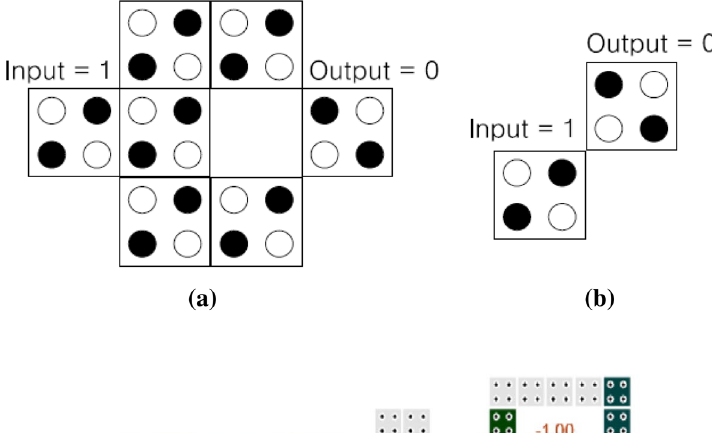
Fig. 3 The QCA inverter gate; a complex gate and b simple gate [8]